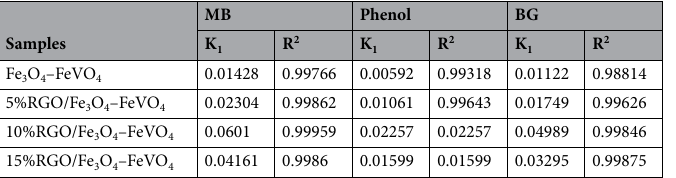
Table 2. Correlation coefficients and rate constants for MB, phenol and BG photodegradation.